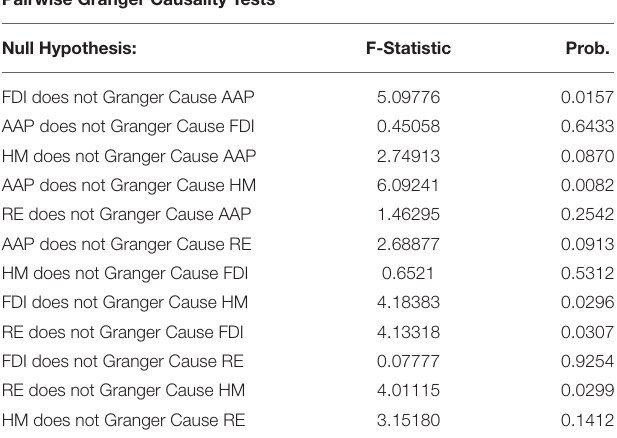
TABLE 4 | Bound test.